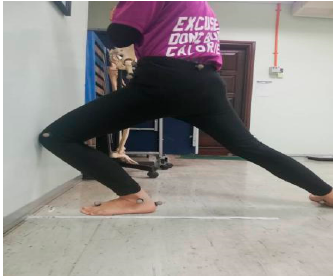
Figure 2. Position of the ankle range of motion test.